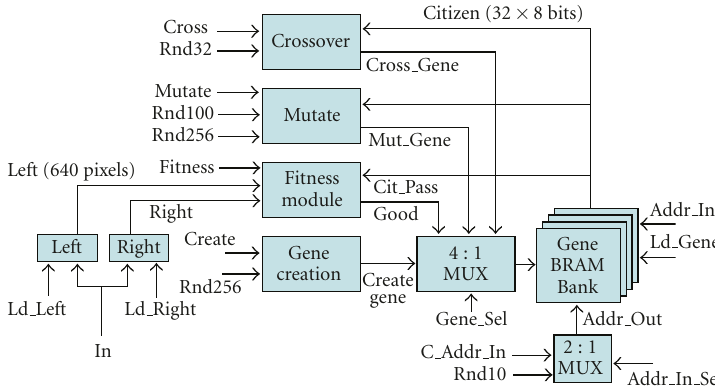
Figure 7: Hardware implementation of genetic